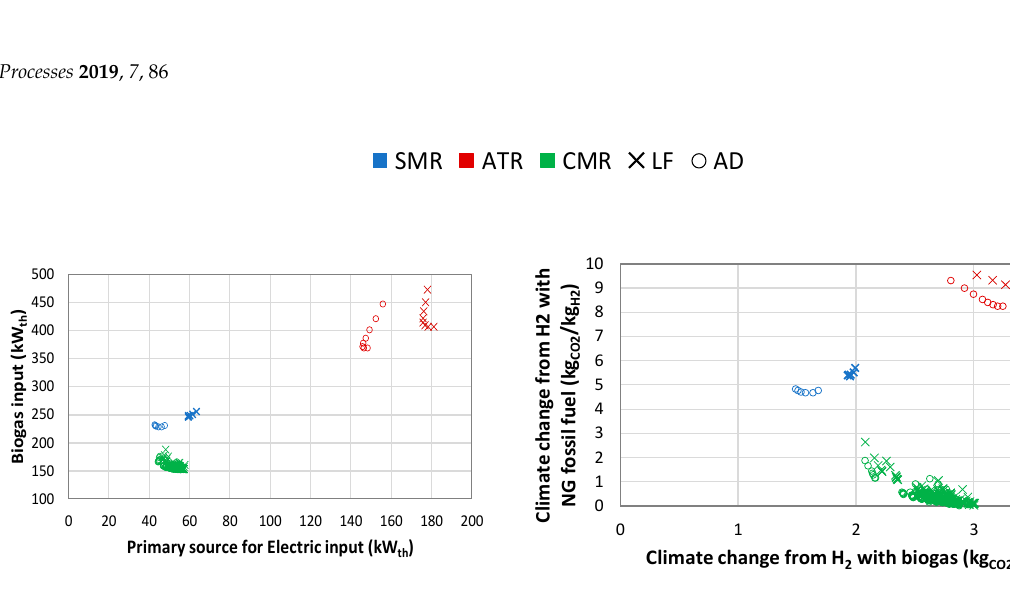
Figure 7. Scenario 1 results: thermal power inputs (electric auxiliary and require biogas) for the three H 2 production systems (left) and climate change impact of H 2 production from biogas and fossil fuel (right).